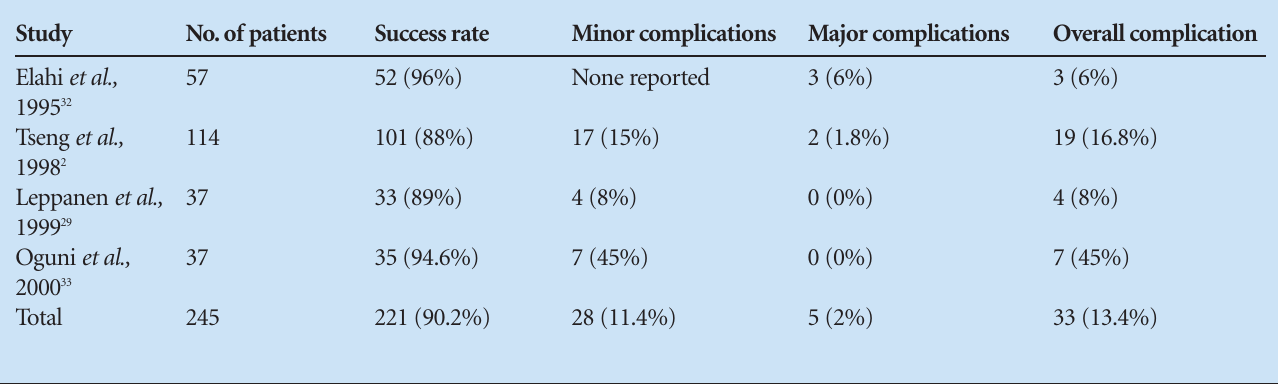
Table V. Reported success and complication rates since